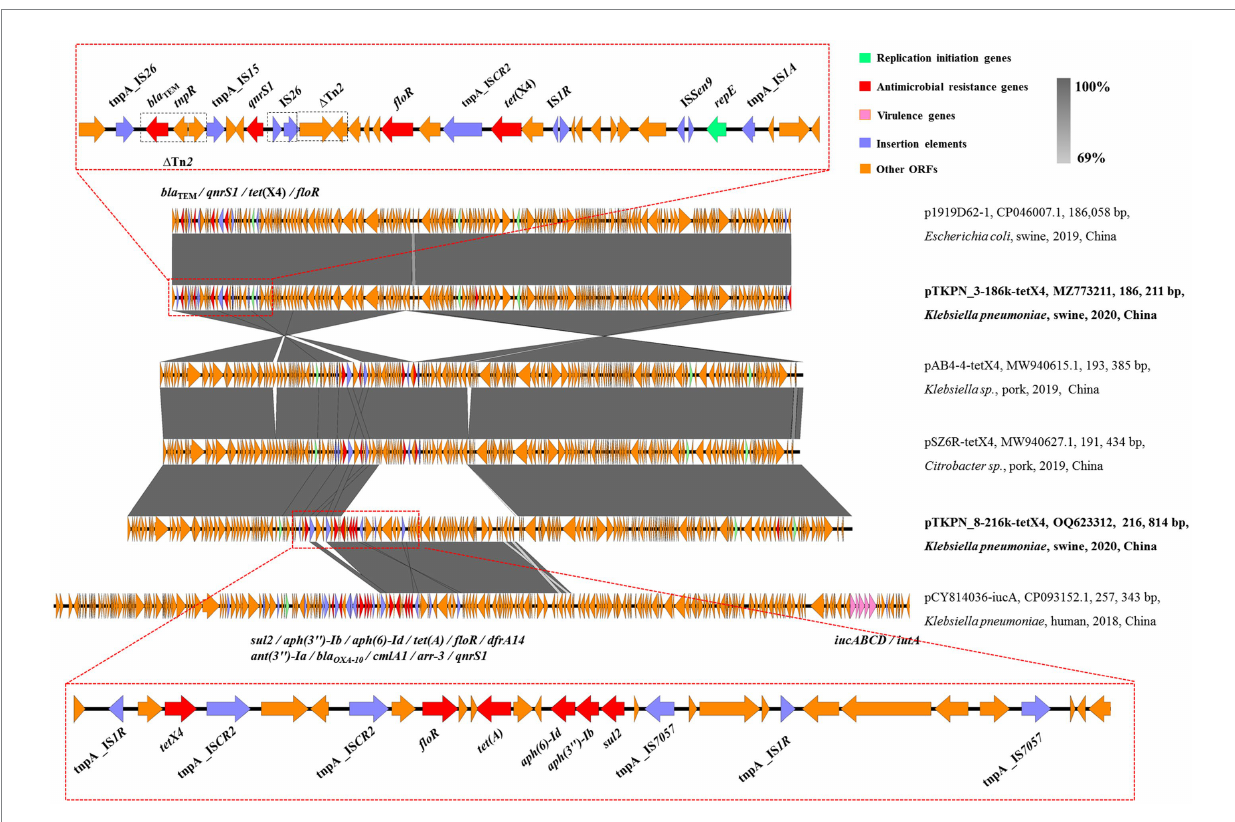
FIGURE 2 Structure analysis of plasmids pTKPN_3-186k-tetX4 and pTKPN_8-216k-tetX4. Major structural features of pTKPN_3-186k-tetX4 and pTKPN_8-216k- tetX4 were compared with those of plasmids p1919D62-1 (GenBank accession no. CP046007.1), pAB4-4-tetX4 (GenBank accession no. MW940615.1), pSZ6R-tetX4 (GenBank accession no. MW940627.1), and pCY814036-iucA (GenBank accession no. CP093152.1). Gray shading indicates shared regions with a high degree of homology (>69%). Red and pink represent the antimicrobial resistance genes and virulence genes, respectively, and purple is the insertion